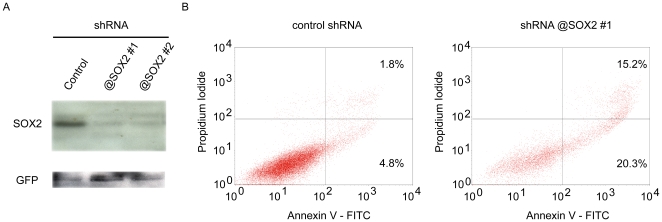
Consequences of shRNA-mediated knockdown of SOX2.
A. Western blot analysis of cells transfected with SOX2-specific shRNA-expressing plasmids. Two shRNAs were found to very efficiently knockdown SOX2 protein expression in 293T cells over-expressing SOX2 (see Materials and Methods). B. FACS analysis of AnnexinV and Propidium Iodide stained BEAS-2B cells. Control and SOX2 shRNA-transduced cells were stained to determine the proportions of cell death by FACS analysis. Proportions of early apoptotic (AnnexinV+/PI-) and late apoptotic/necrotic (AnnexinV+/PI+) cells are strikingly increased in SOX2 knockdown cells.